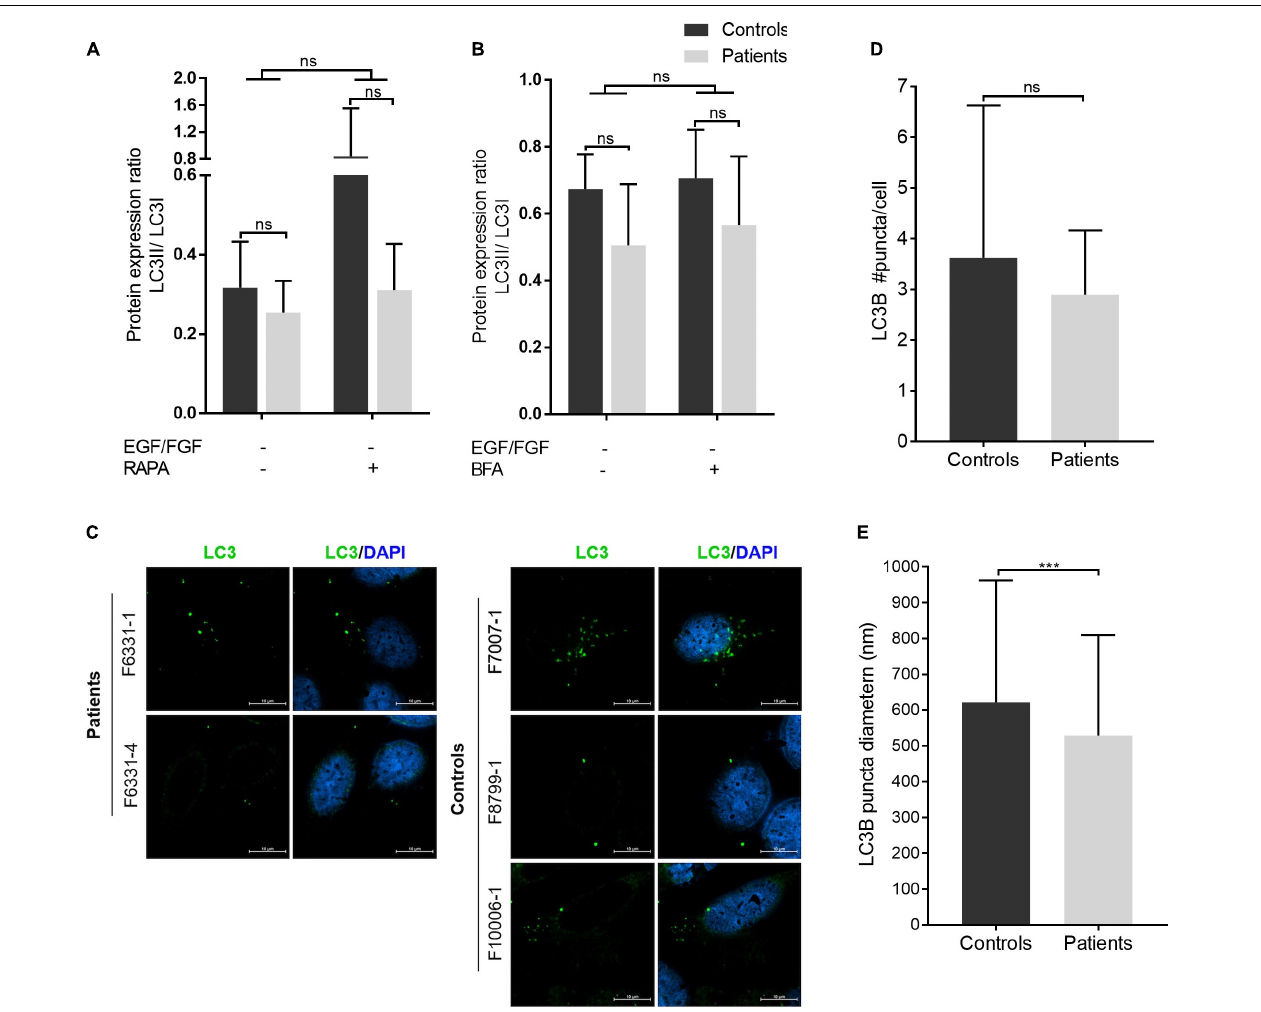
FIGURE 4 | Autophagosome biogenesis analysis: LC3B puncta diameter is reduced in patient-derived iNPC. (A,B) Graphs show the densitometries of immunoblots shown in Supplementary Figure 4 . Patients are represented in gray ray bars and controls in black bars. Graphs show the LC3A-B II/I ratio from iNPC cultivated under normal growth conditions and under stress-inducing conditions: absence of EGF and fibroblast growth factor-2 (FGF-2) for 24 h and (A) concomitant treatment with rapamycin (100 nM) for 24 h, and (B) subsequent treatment with BFA (4 µ M) for 3 h. β -actin was used as a loading control. Graphs are represented in arbitrary units. (C–E) Immunostaining analysis of endogenous LC3B by confocal microscopy. Representative images are presented in panel (C) ; average LC3B puncta diameter (nm) in panel (D) ; and an average number of LC3B puncta per cell in panel (E) . *** p -value < 0.001; n.s.—not significant. Data are shown as mean values ± SD of biological replicates. Patients: F6331-1 and F6331-4 ( N = 2); controls: F7007-1, F8799-1, and F10006-1 ( N =